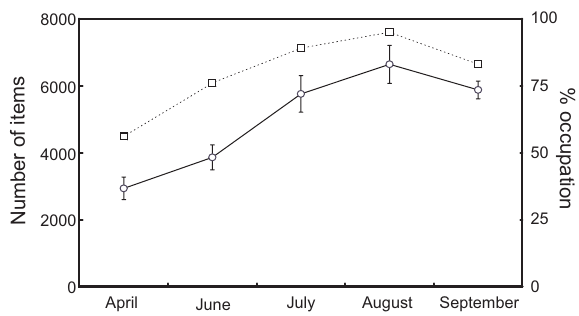
F IG . 3. – Monthly variation of mean (±SD) number of debris items (open circles) and percentage of hotel occupation for the corresponding date (squares). Data from CITTIB, 2005.